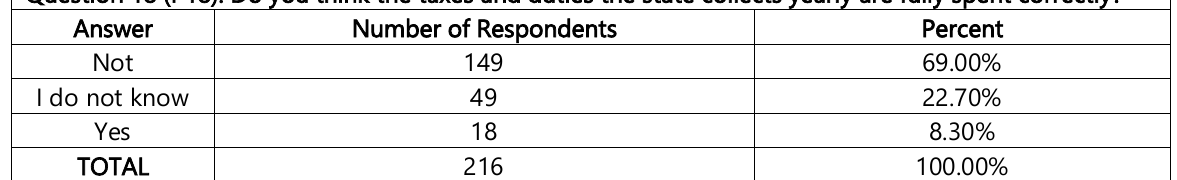
Table 4: Overview of the Perception of State Budget Spending (Source: Authors’ calculation)